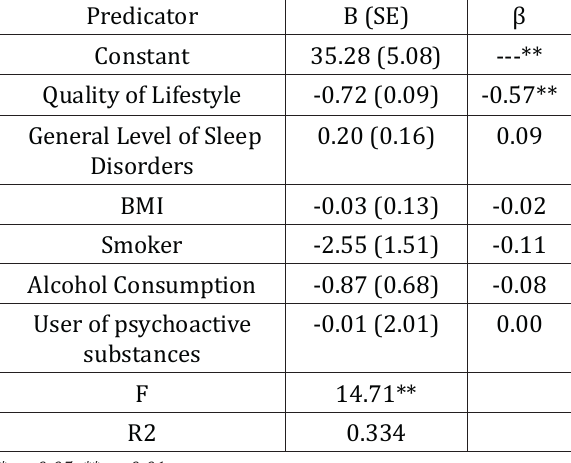
Table 3. Predictors of mental health disorders